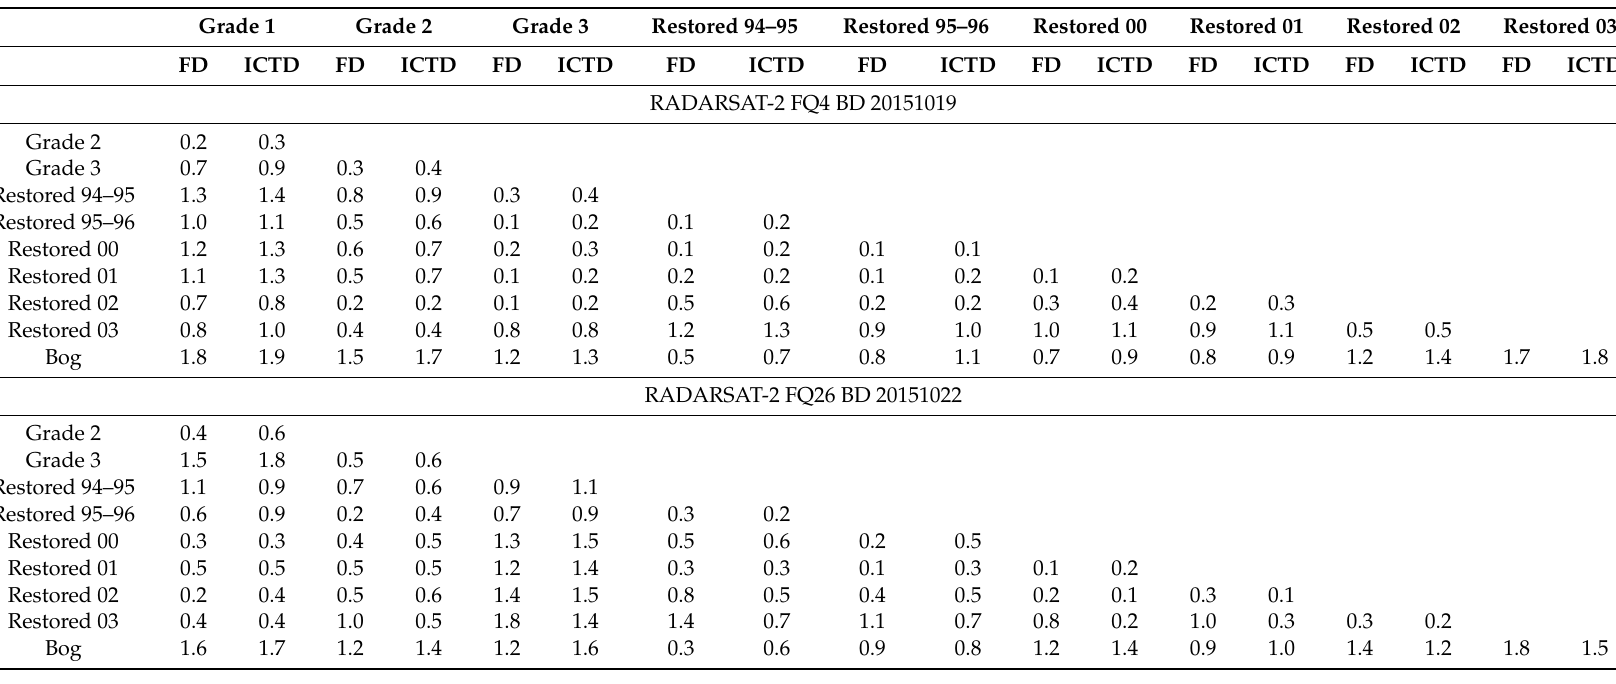
Table 4. Results of the Bhattacharya distance (BD) statistic comparing the separability of the spectral responses for natural shrub bog, restored peat, and actively harvested using the RADARSAT-2 FQ4 19 October 2015, and FQ26 22 October 2015 images. All values equal to or greater than 1.9 suggest good spectral separability and values below 1.9 suggest poor